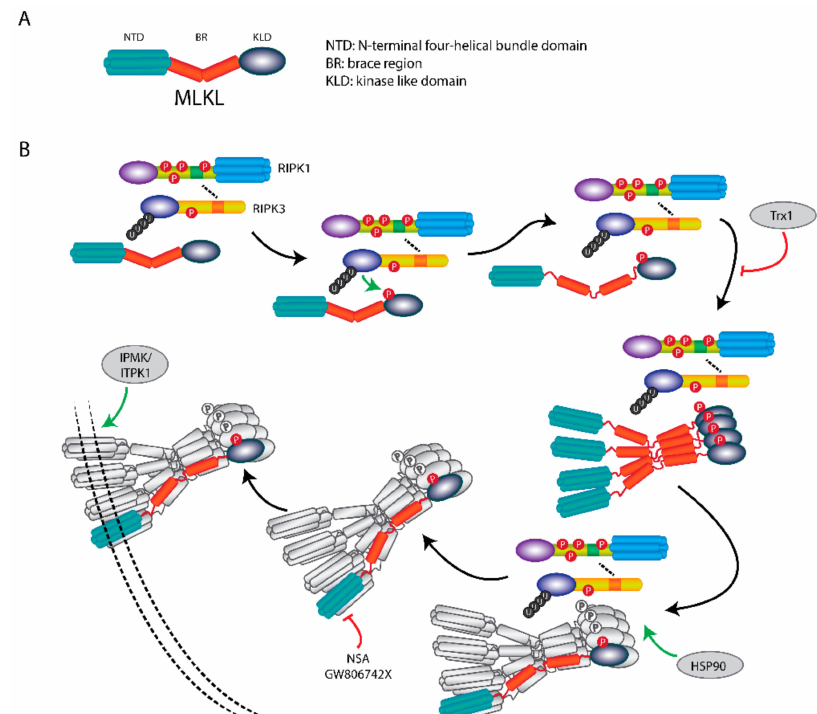
Figure 4. MLKL translocation and membrane association induce necroptosis. ( A ) Scheme of